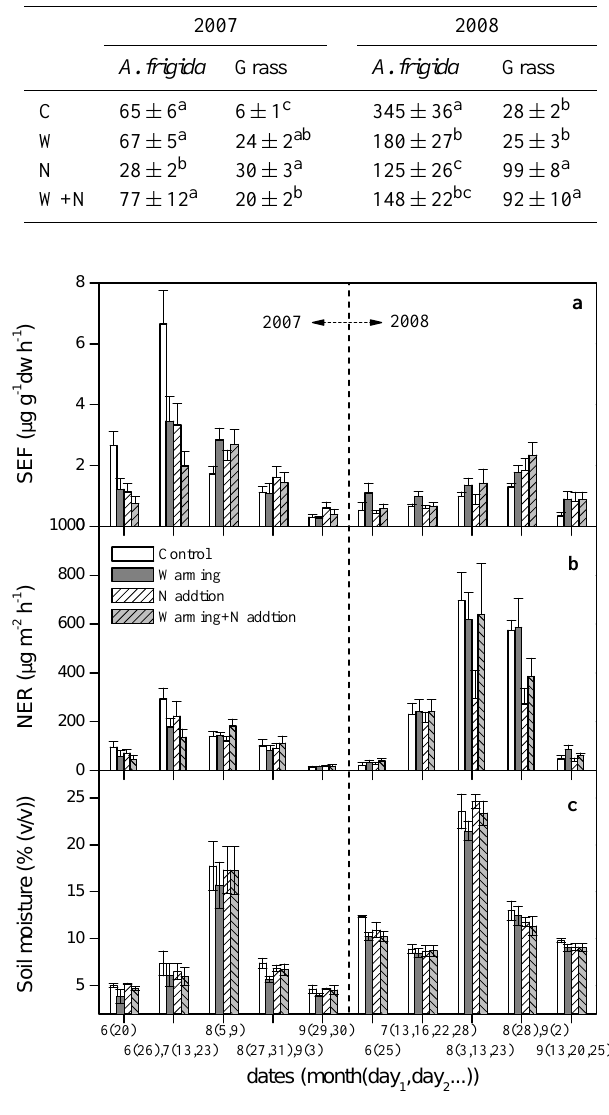
Fig. 3. Temporal variation of standard monoterpene emission rate (SEF, mean+1SE) (a) and natural monoterpene emission rate (NER, mean+1SE) (b) , and soil moisture (mean ± 1SE) (c) in 2007 and 2008. affected NER (Table 3), while they both decreased SEF by 24–25 % ( p < 0 . 05). If the measurements in each sampling day were analysed separately, the negative effects of warm- ing on SEF were found to be most pronounced (reduced by 38 %, p = 0 . 02) when SM was lower than 9 % ( v / v ), and significant positive effect of warming (58 %, p = 0 . 04) was detected in 5–9 August when SM was more than 15 % ( v / v